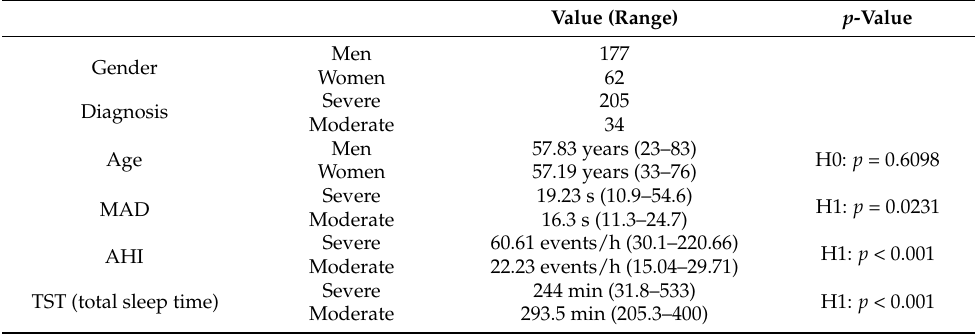
Table 1. Basic anthropometric factors and indices associated with Sleep Apnea Syndrome (SAS), for the population participating in this study.